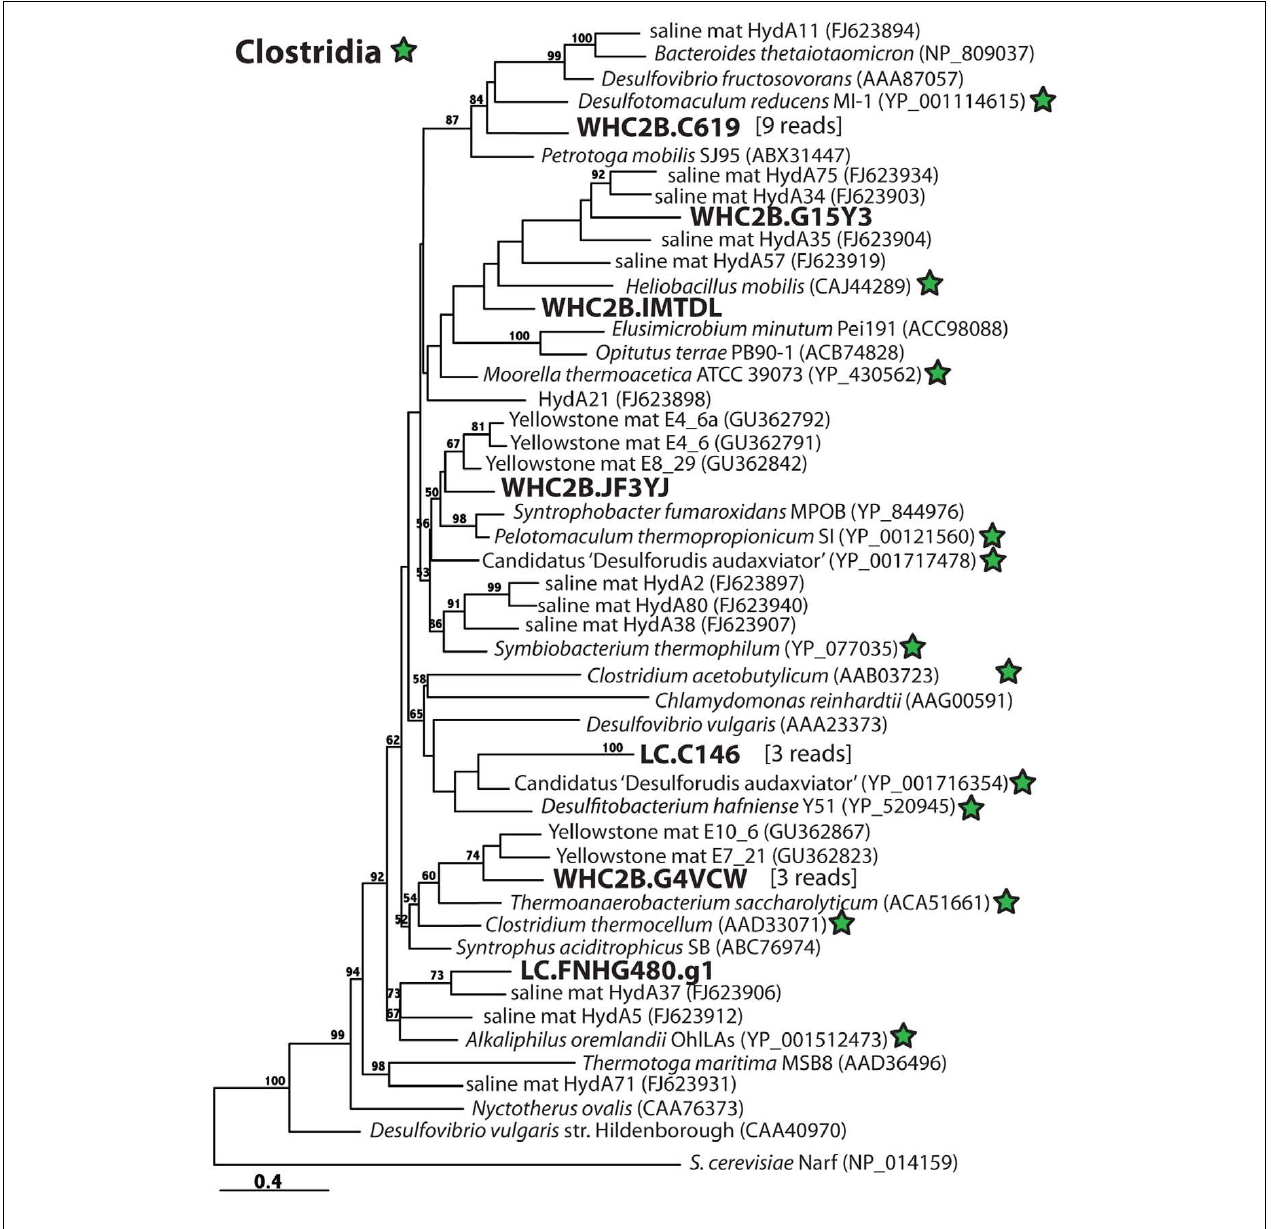
sequences are in large, bold font.The number of metagenomic shotgun sequencing reads associated with each representative on the tree is indicated in brackets. Maximum-likelihood bootstrap support values > 50 are